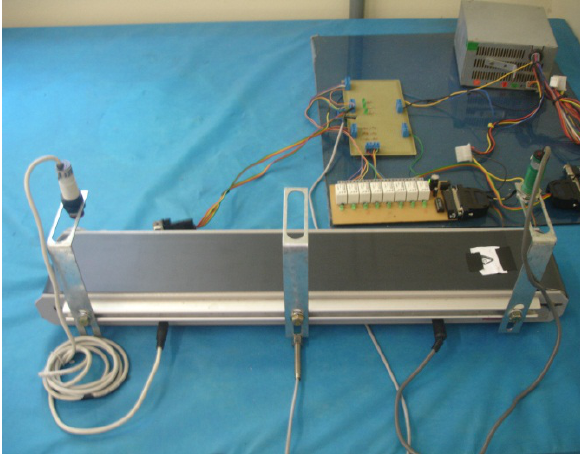
Figure 6. Simple bottling plant and